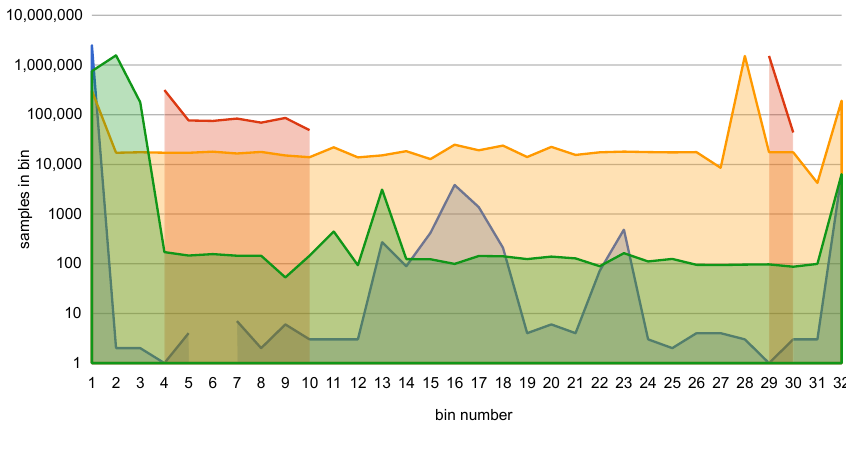
Figure 4. Samples per bin for PM dataset U RES channel ( m = 32). Note the logarithmic